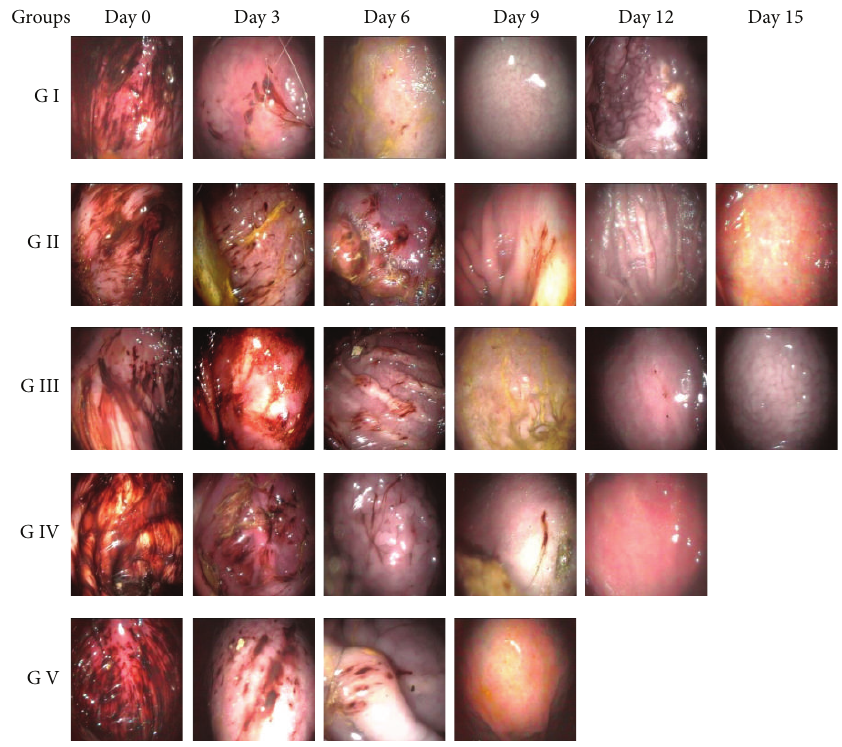
Figure 1: Endoscopic view of gastric mucosal surface of dogs in different groups at various observation intervals.